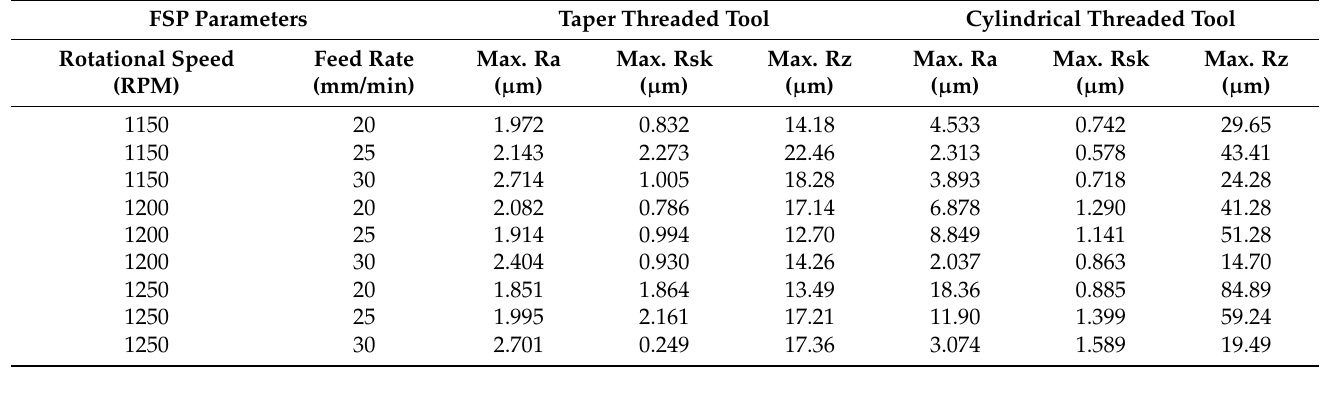
Table 2. Maximum arithmetic roughness (Ra), skewness (Rsk), and average peak-valley (Rz) values produced by different processing parameters with different FSP tool pin geometry.